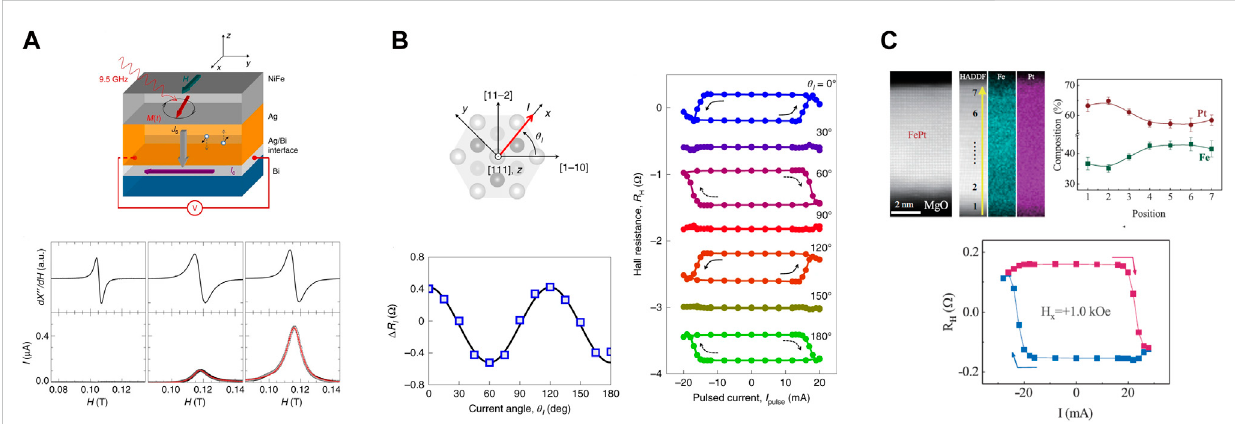
FIGURE 3 Emergence of SCCs due to spatial inversion symmetry breaking. (A) Spin-to-charge conversion at Ag/Bi Rashba interface in [44]. The bottom fi gure correspondstoFMRandspinpumpingspectrainNiFe/Ag,NiFe/Bi,andNiFe/Ag/Bi fi lms.Aclearenhancementappearsduetospin-to-chargeconversion at Ag/Bi. (B) CuPt/CoPt Hall devices for symmetry-dependent SOT-induced magnetization switching in [52]. Plane view of the L 11 hexagon projected along the [111] direction, where the Pt atomic layer (grey color) is sandwiched between two Cu (Co) atomic layers. The polarity of magnetization switching(clockwiseandanti-clockwise)dependsonthecurrentangle θ l fromthelow-symmetryaxis[1 – 10]ofCuPt. (C) Self-inducedSOTswitchingina single ferromagnetic layer in [57]. A composition gradient exists in FePt along the thickness direction.